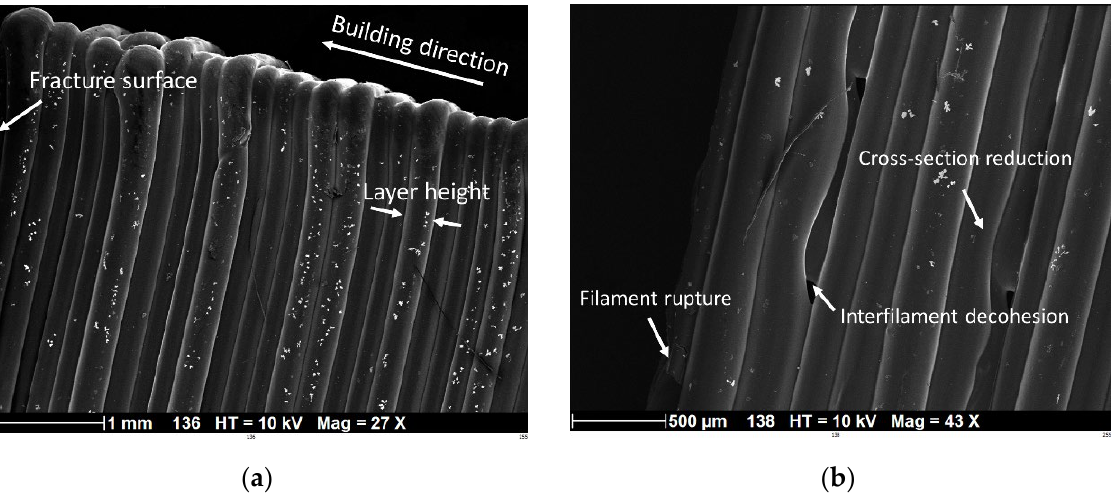
Figure 11. SEM micrographs of fractured surface of 3D-printed PLC according to vertical orientation (HA) (printing angle θ = 45°): ( a ) overall view normal to the sample thickness, and ( b ) zoomed-in view of the fracture surface.